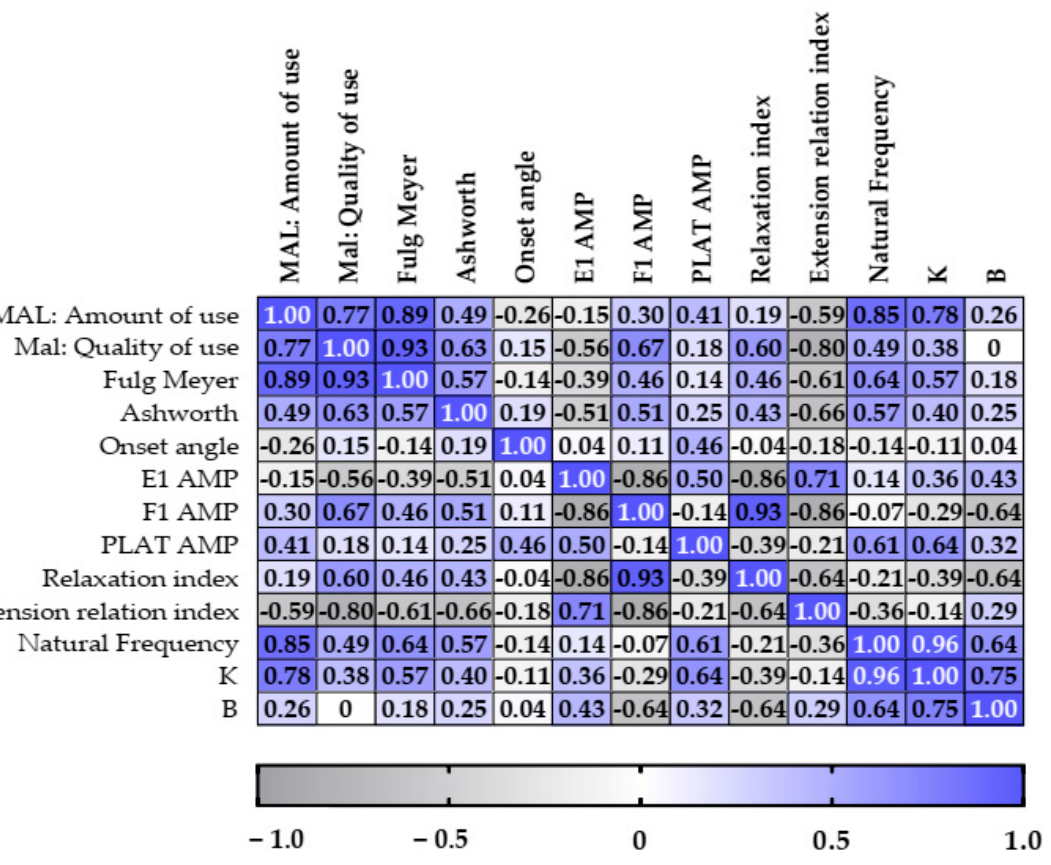
Figure 3. Representation of the pendulum tests using the inertial sensor: Flexion and extension peaks represented by the blue dots, according to the trajectory of angles ( ◦ ) and time (s) for participants #4, #5, #6, and #7.